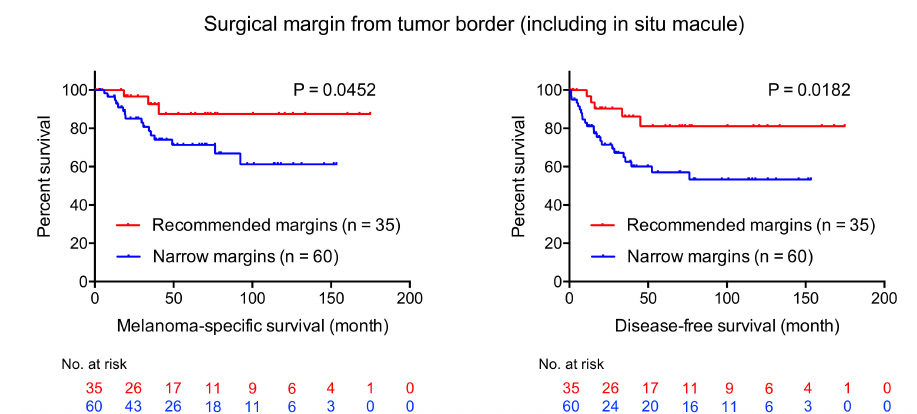
Figure 3. Kaplan-Meier survival curves for melanoma-specific survival (MSS) and disease-free survival (DFS). Narrow-margin excision is a significant factor for worse prognosis both for MSS and DFS when surgical margins were measured from the lateral tumor borders (5-year survival, 71.3% vs. 87.5%, 57.1% vs. 81.1%, p = 0.0452 and p = 0.0182,